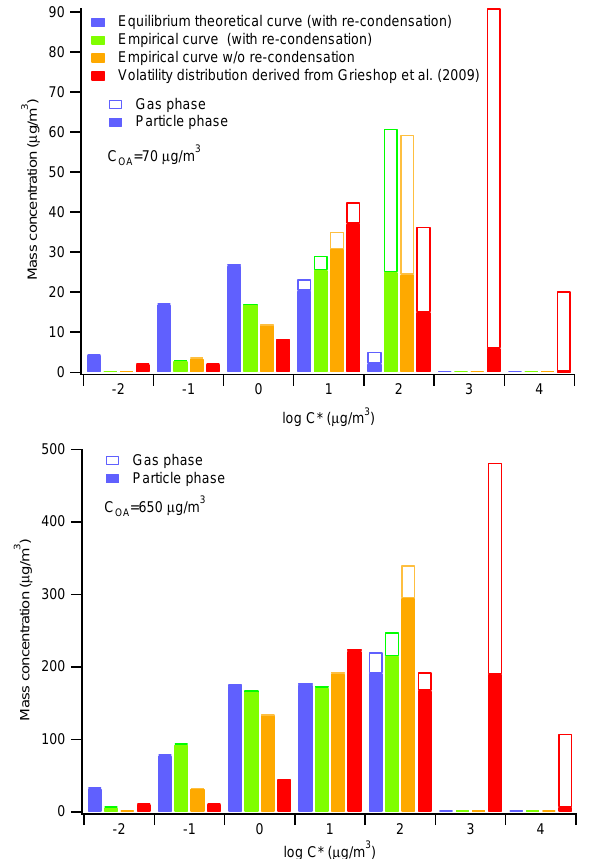
Fig. 14. Volatility distributions derived from lubricating oil ther- mograms at 70 and 650µgm − 3 aerosol loading, using the equi- librium and empirical calibration curve approach. For 70µgm − 3 (a) the thermogram considerably deviates from equilibrium (Fig. 8 and S5), thus, resulting in the equilibrium calibration approach un- derestimating the aerosol volatility. The empirical calibration pro- vides a better agreement in this case, due to the calibration curve fortuitously laying on the empirical calibration curve (Fig. S5). For the highest aerosol loading (b) , the thermograms are close to equilibrium (Fig. 8 and S5) and the predictions approach the distribution derived using the volatility basic-set distribution by Grieshop et al.